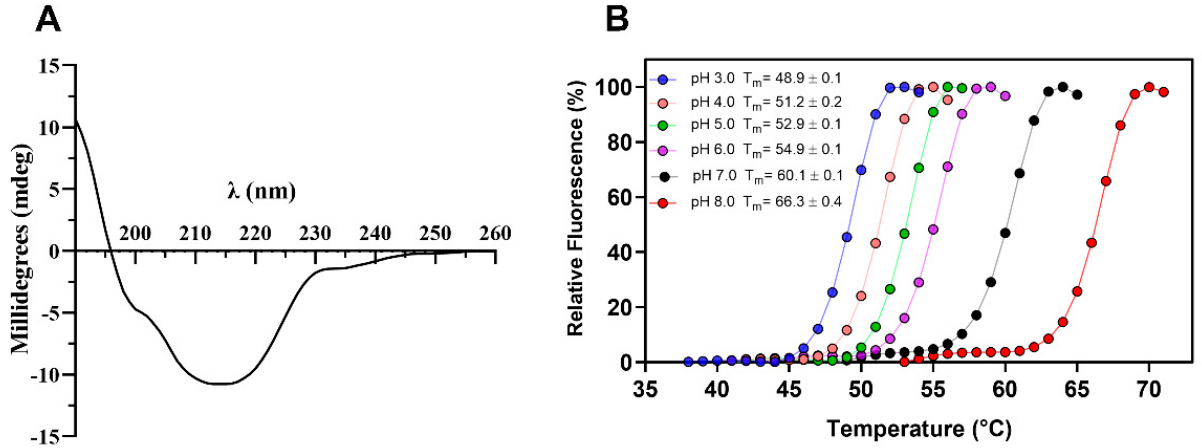
Figure 4. ( A ) Secondary structure profile of Tt Cel7B determined by CD spectroscopy. ( B ) Thermal stability curves of Tt Cel7B at different pH and determination of melting temperature (Tm).